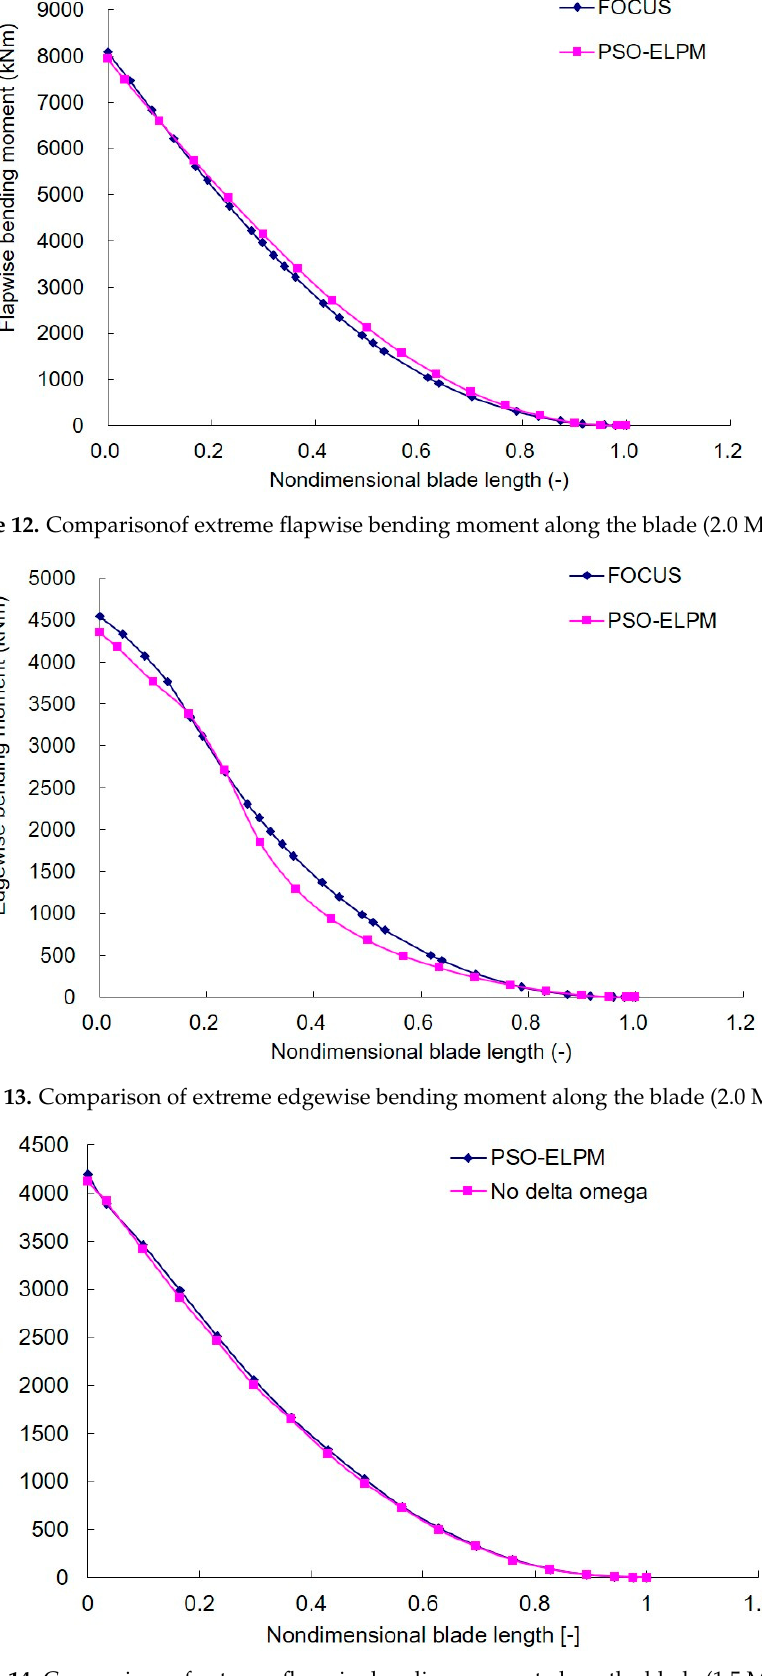
Figure 14. Comparison of extreme flapwise bending moment along the blade (1.5 MW).